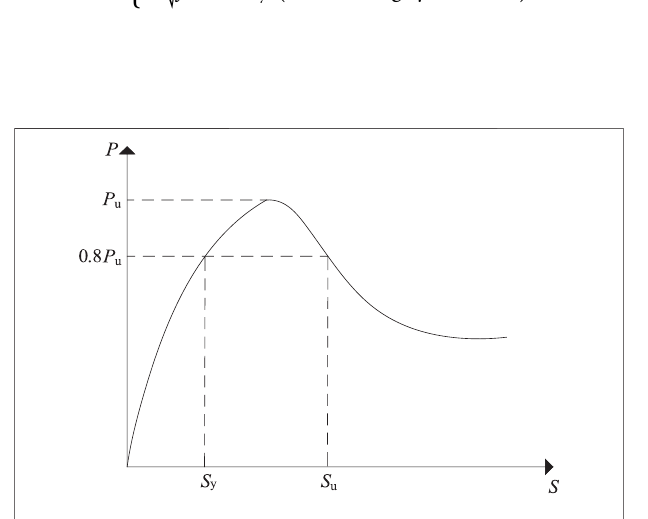
FIGURE 11 | Ductility coef fi cient